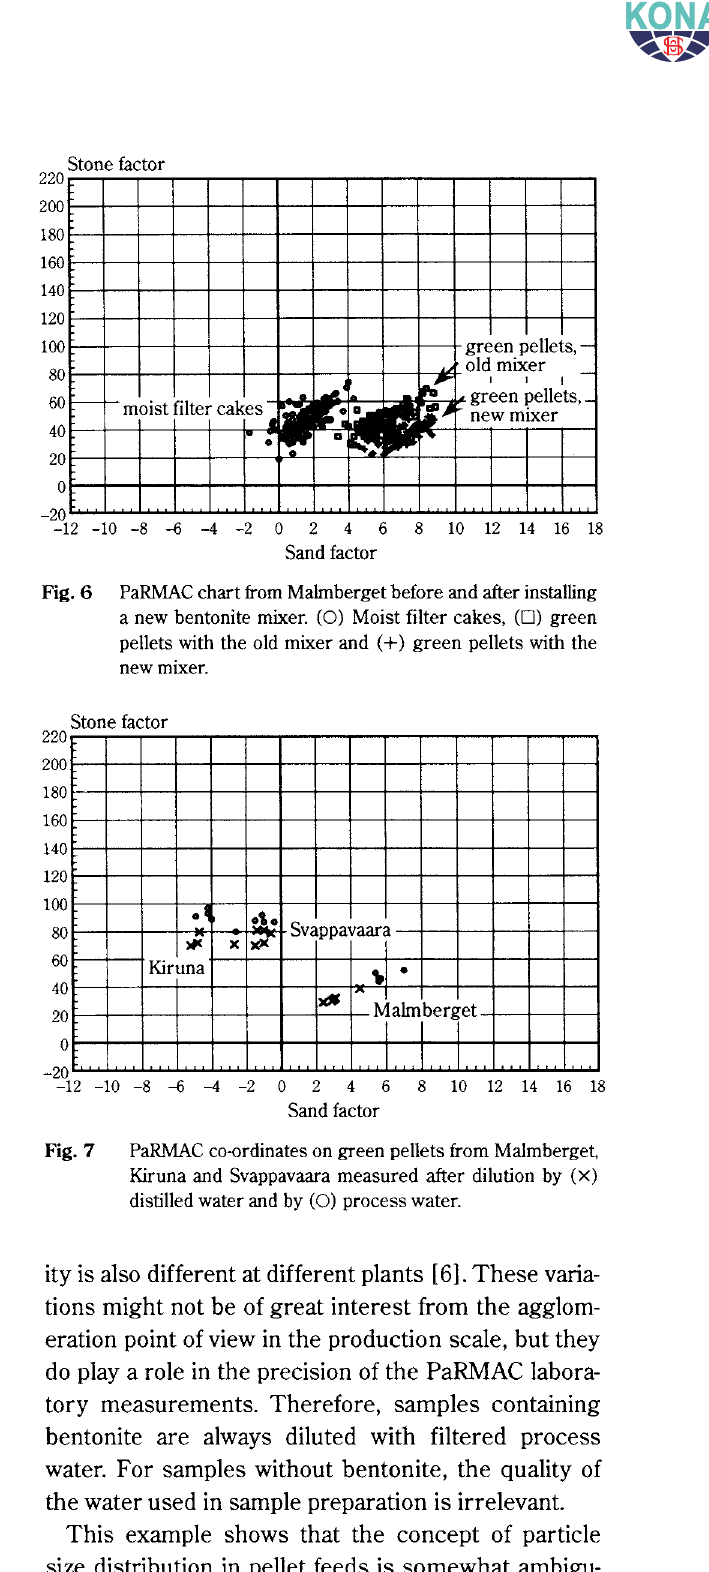
Fig. 6 PaRMAC chart from Malmberget before and after installing a new bentonite mixer. (0) Moist filter cakes, (D) green pellets with the old mixer and ( +) green pellets with the new mixer.